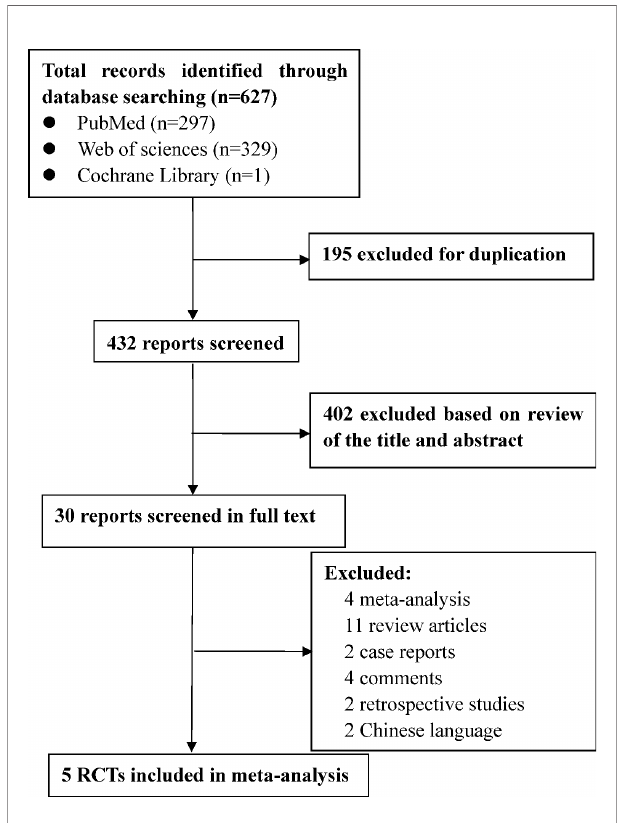
FIGURE 1 | Flow chart of the study selection strategy.